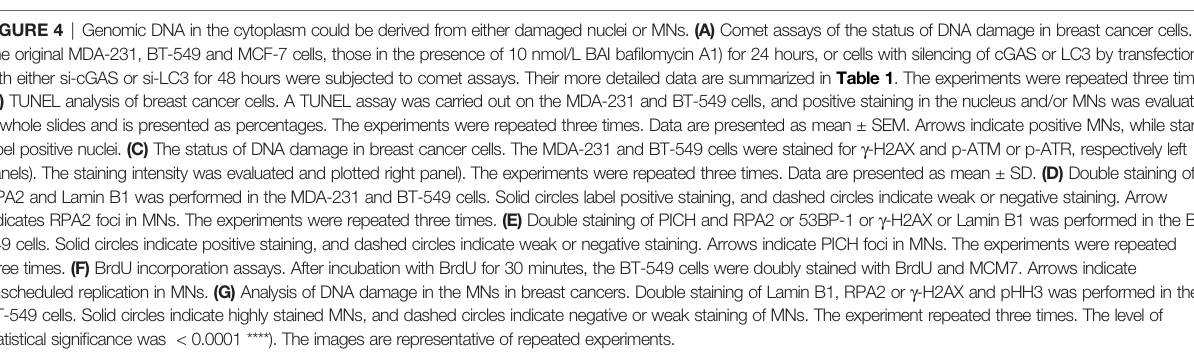
FIGURE 4 | Genomic DNA in the cytoplasm could be derived from either damaged nuclei or MNs. (A) Comet assays of the status of DNA damage in breast cancer cells. The original MDA-231, BT-549 and MCF-7 cells, those in the presence of 10 nmol/L BAI ba fi lomycin A1) for 24 hours, or cells with silencing of cGAS or LC3 by transfection with either si-cGAS or si-LC3 for 48 hours were subjected to comet assays. Their more detailed data are summarized in Table 1 . The experiments were repeated three times. (B) TUNEL analysis of breast cancer cells. A TUNEL assay was carried out on the MDA-231 and BT-549 cells, and positive staining in the nucleus and/or MNs was evaluated in whole slides and is presented as percentages. The experiments were repeated three times. Data are presented as mean ± SEM. Arrows indicate positive MNs, while stars label positive nuclei. (C) The status of DNA damage in breast cancer cells. The MDA-231 and BT-549 cells were stained for g -H2AX and p-ATM or p-ATR, respectively left panels). The staining intensity was evaluated and plotted right panel). The experiments were repeated three times. Data are presented as mean ± SD. (D) Double staining of RPA2 and Lamin B1 was performed in the MDA-231 and BT-549 cells. Solid circles label positive staining, and dashed circles indicate weak or negative staining. Arrow indicates RPA2 foci in MNs. The experiments were repeated three times. (E) Double staining of PICH and RPA2 or 53BP-1 or g -H2AX or Lamin B1 was performed in the BT- 549 cells. Solid circles indicate positive staining, and dashed circles indicate weak or negative staining. Arrows indicate PICH foci in MNs. The experiments were repeated three times. (F) BrdU incorporation assays. After incubation with BrdU for 30 minutes, the BT-549 cells were doubly stained with BrdU and MCM7. Arrows indicate unscheduled replication in MNs. (G) Analysis of DNA damage in the MNs in breast cancers. Double staining of Lamin B1, RPA2 or g -H2AX and pHH3 was performed in the BT-549 cells. Solid circles indicate highly stained MNs, and dashed circles indicate negative or weak staining of MNs. The experiment repeated three times. The level of statistical signi fi cance was < 0.0001 ****). The images are representative of